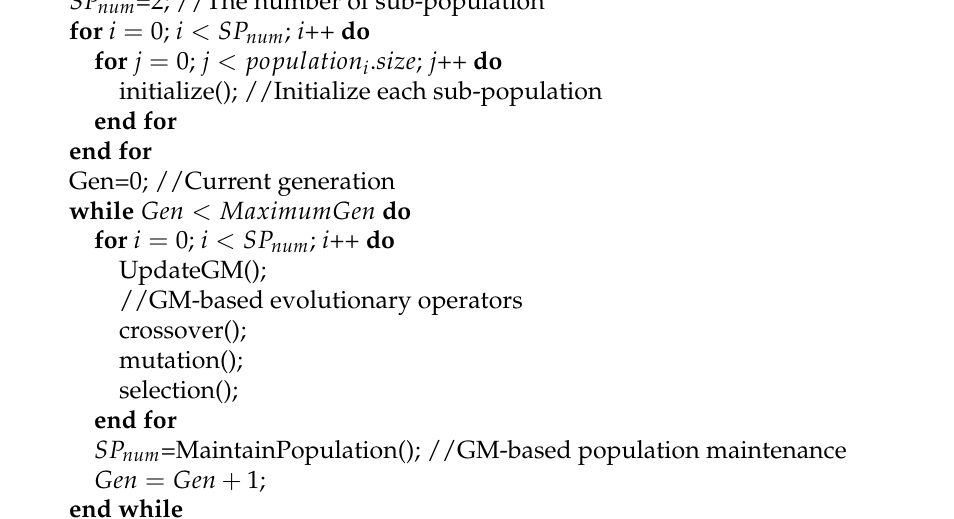
Algorithm 1: The framework of adaptive multi-modal multi-objective